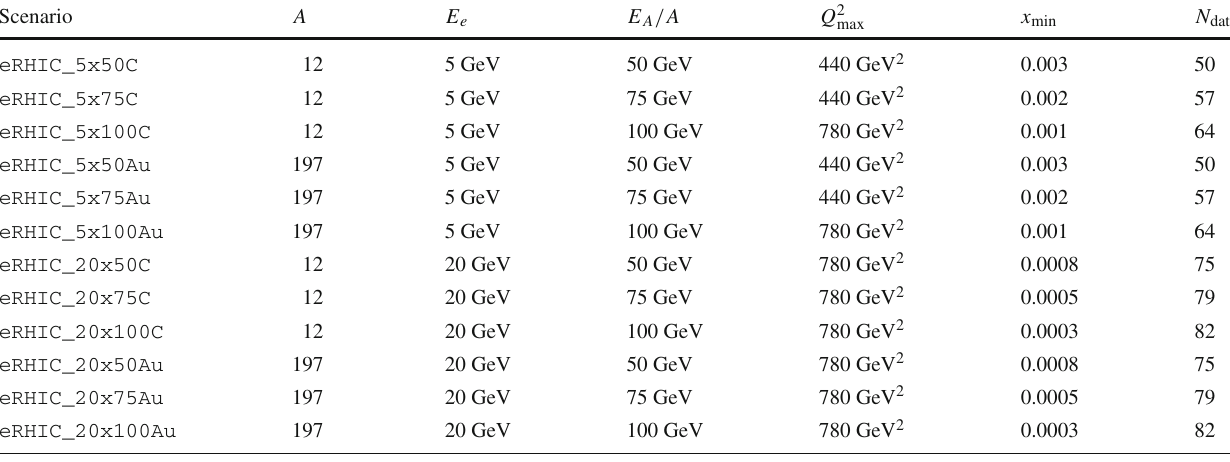
of pseudo-data points N dat . The upper part of the table corresponds to the “low energy” scenario (with E e = 5 GeV) while the lower one to the “high energy” scenario (with E e = 20 GeV)